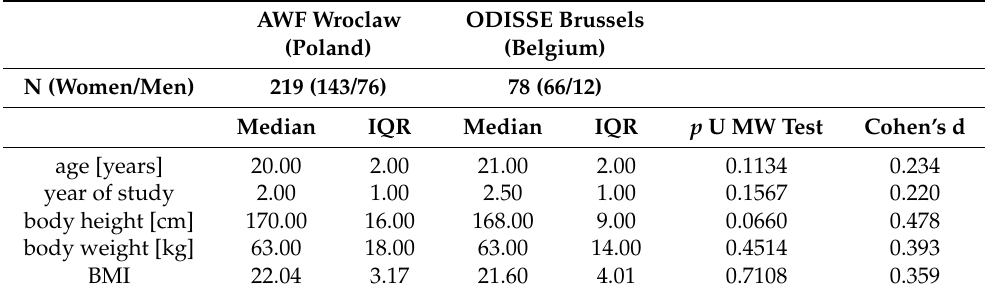
Table 1. Research